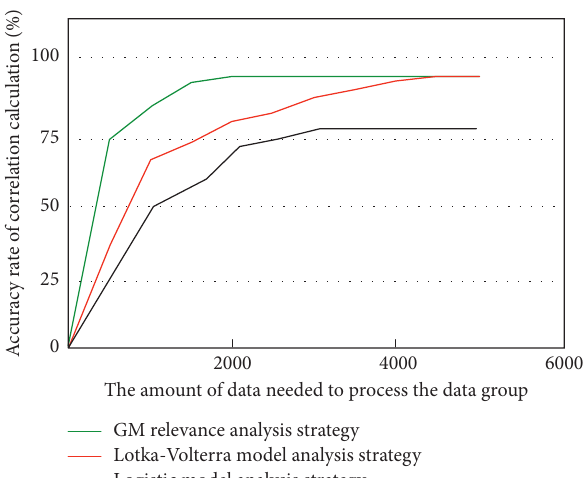
Figure 5: The calculation accuracy of the correlation degree corresponding to the three different correlation degree analysis strategies.